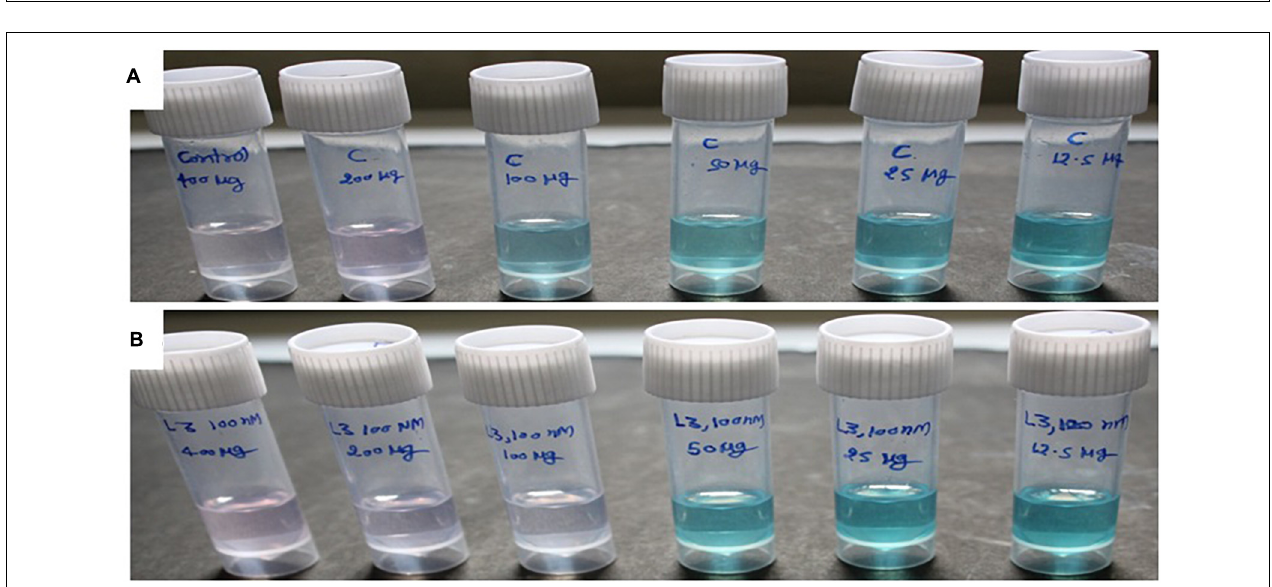
Frontiers in Microbiology |